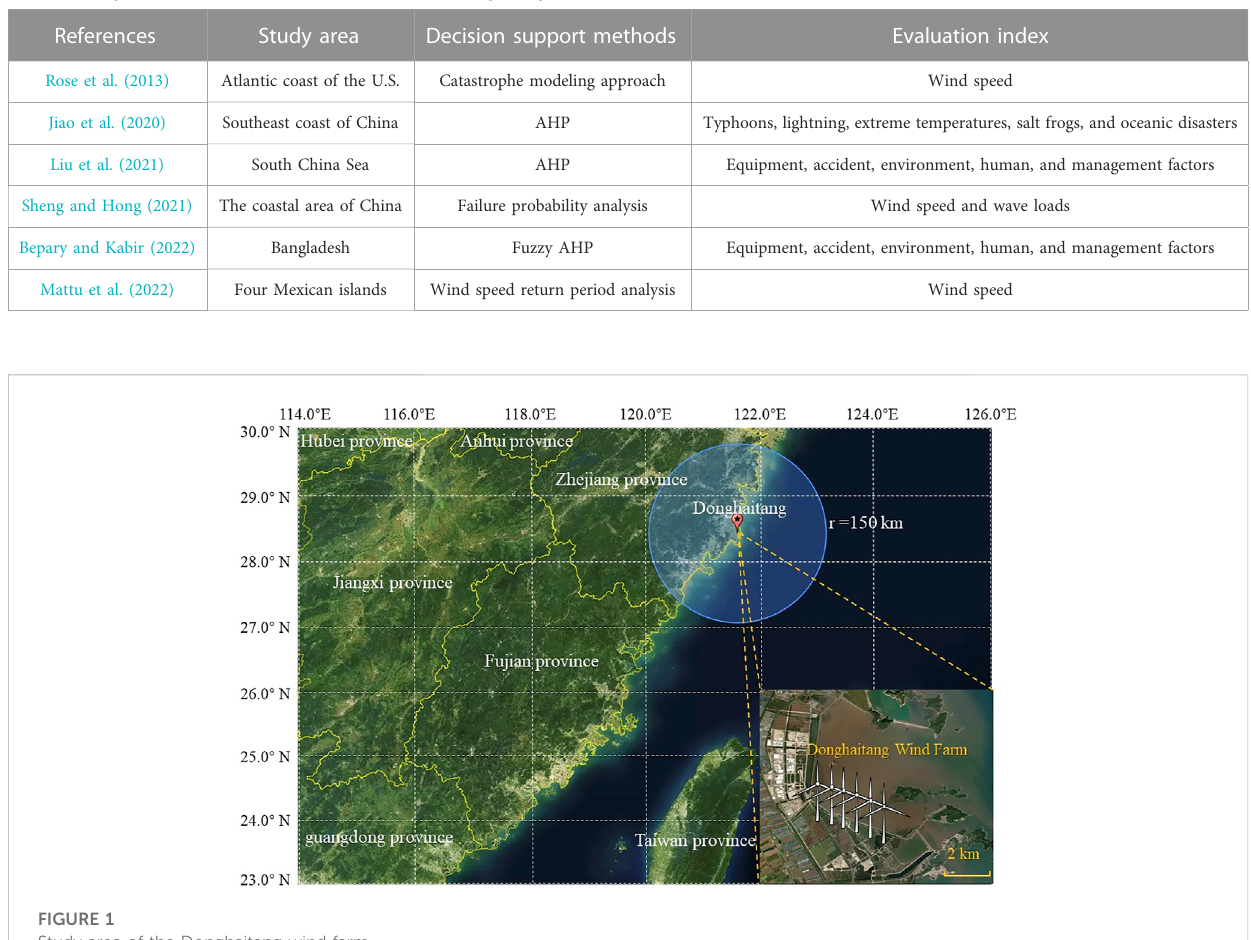
TABLE 1 Comparison of historical researches on different tropical cyclone disaster assessment methods for offshore wind farms.